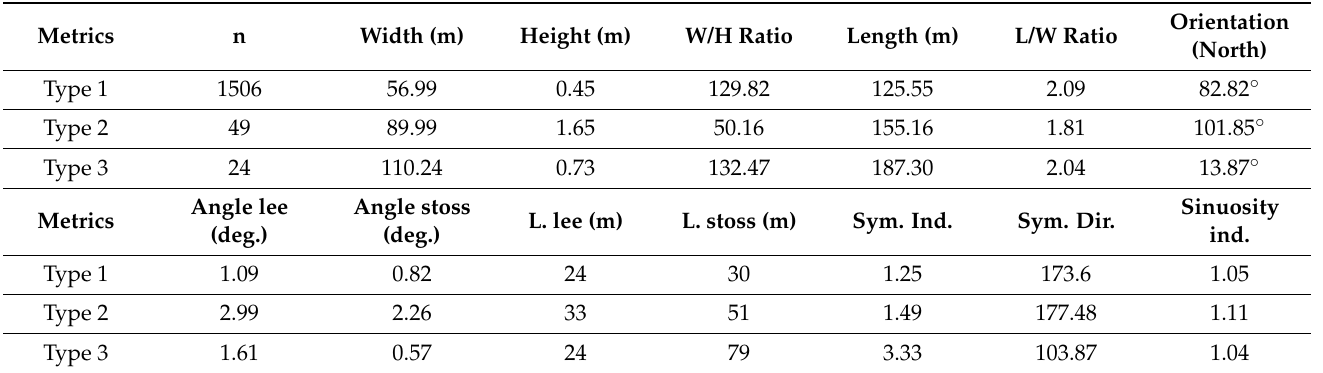
Figure 15. Comparison of Point Cloates bedform metrics. Elevation vs. orientation ( A ), lee angle vs. stoss angle ( B ), width vs. height ( C ) and width vs. length ( D ). Table 5. Automated metrics (median value) from Point Cloates